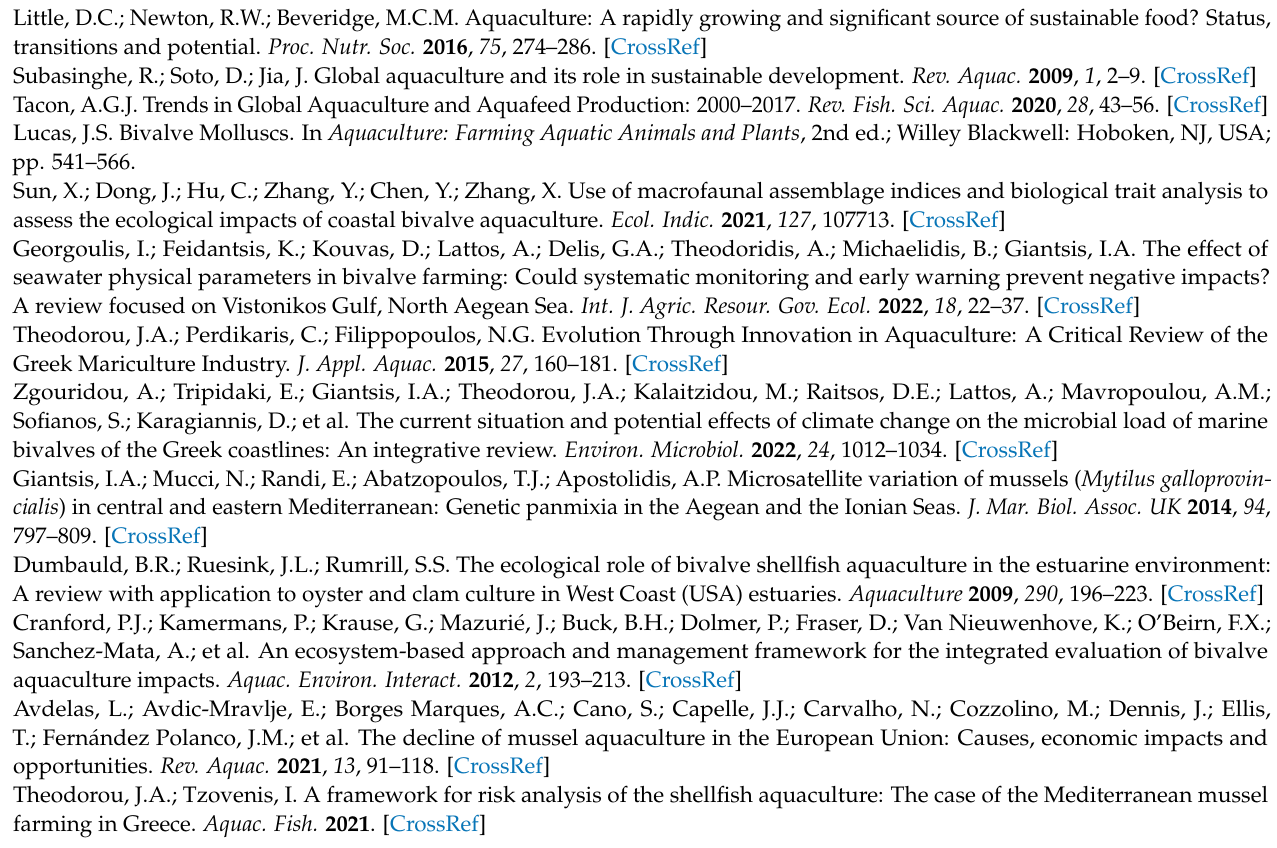
Figure S4: The complete original immunoblots shown in Figure 11 are presented in order below. The individual parts comprising Figure 11 are specified using black